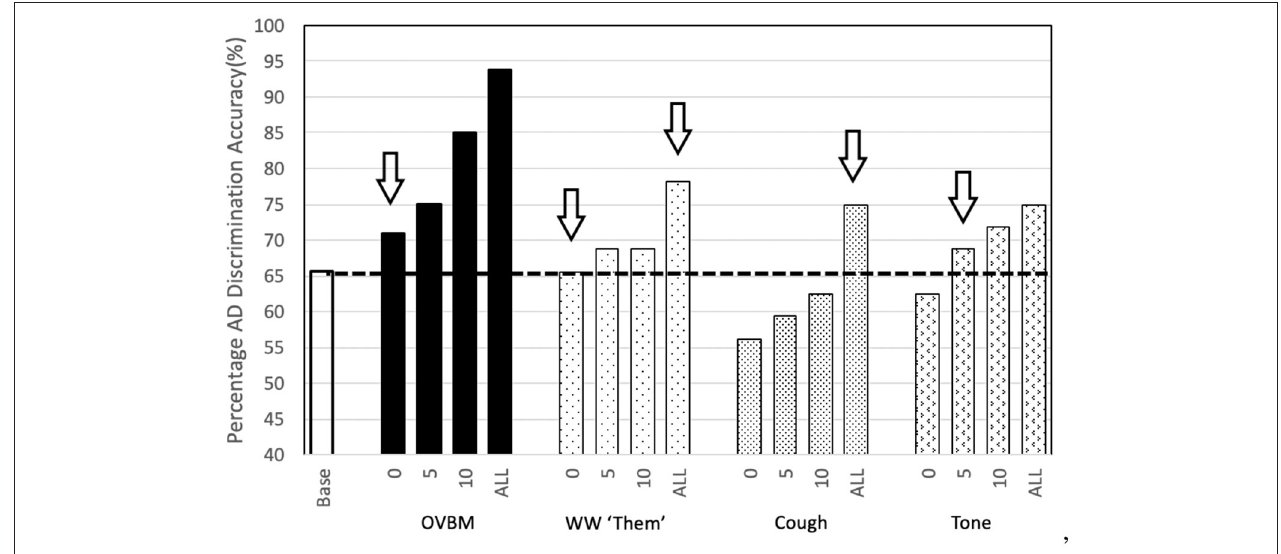
FIGURE 4 | Sensory Stream Saliency Bar Chart: To illustrate the potential of our approach we show the strength of the simplest transfer models we tried. The numbers 0-5-10-ALL on the x-axis labels refer to the number of convolution layers trained after transfer learning in addition to the final dense layer. We find the most surprising, perhaps, is that the simple wakeword model to find the word “Them” is as powerful as the baseline. If we let the model fine-tune the last few (0-5-10) layers then it goes well beyond it. Our novel Cough database, inspired in the effect of AD in the respiratory tract also shows surprising results, even without any adaptation at all. If we let fine-tuning of the whole model, it’s validation accuracy improves ≈ 10% points with respect to the baseline. Baseline is the same OVBM architecture trained on AD without any transfer learning of features.